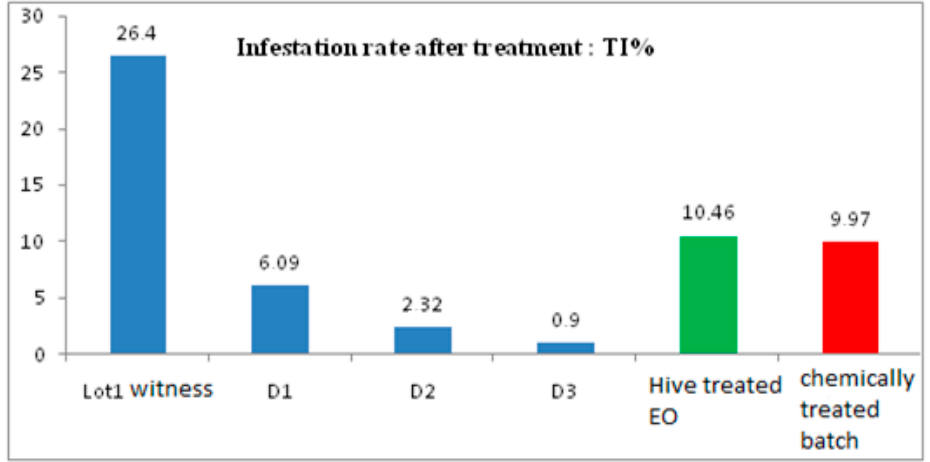
Figure 1. Infestation rate after treatment. EO: Essential Oil.